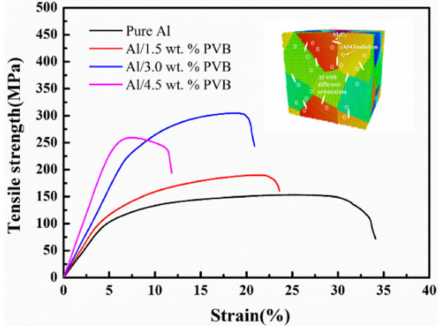
Figure 5. The tensile strength of the C-O / Al composite modified by di ff erent PVB contents and pure Al sintered at 630 ◦